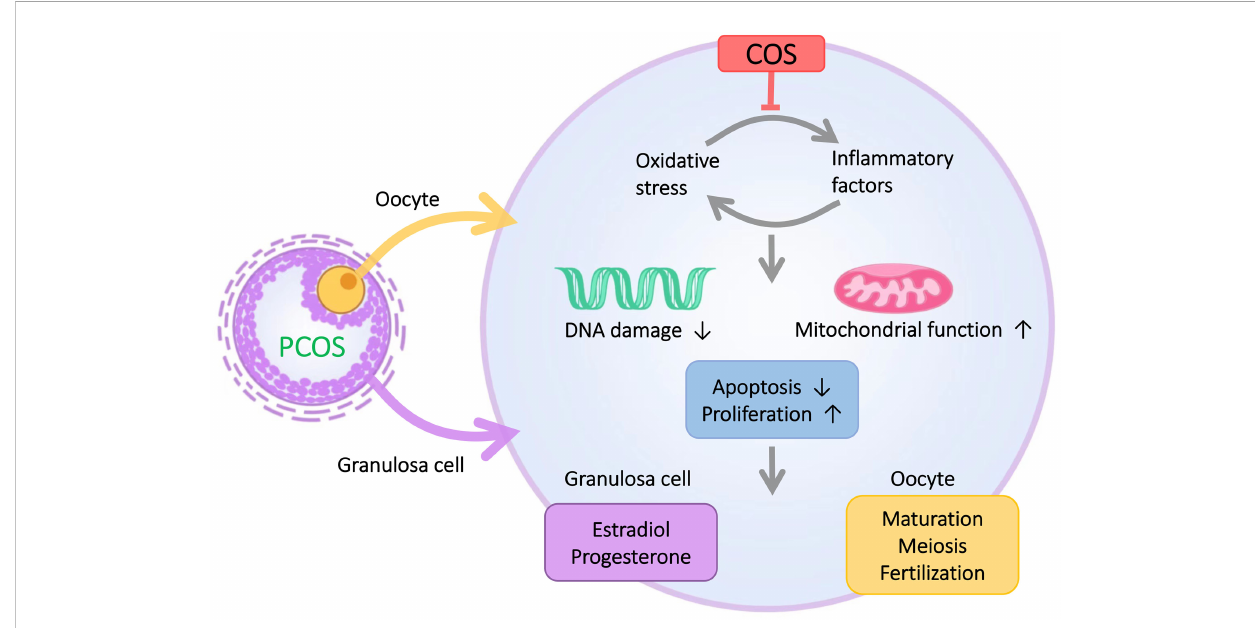
FIGURE 6 The microenvironment of GCs in PCOS patients is characterized by in fl ammation and oxidative stress. COS improves the in fl ammation and oxidative stress of GCs and thus enhances the proliferative capacity of GCs, reduces the apoptotic level of GCs, and ultimately improves abnormal follicular development in PCOS patients.